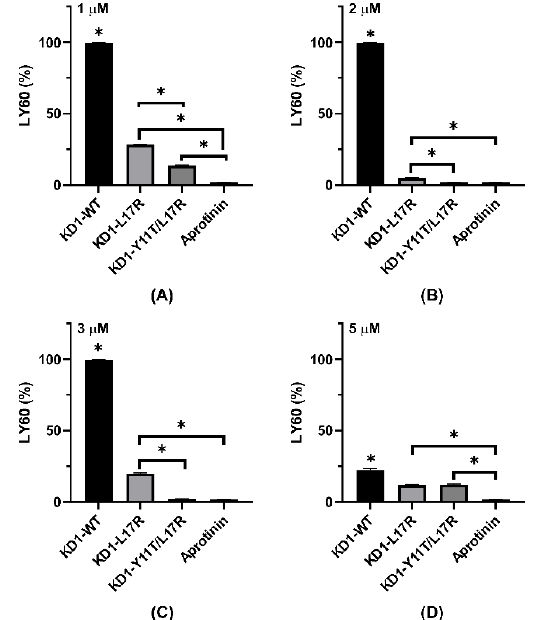
Figure 10. Comparison of LY60% (TEG experiments) for KD1-WT, KD1-L17R-K COOH , KD1- Y11T/L17R-K COOH and aprotinin at different concentrations. Bar graphs showing the percent lysis at 60 min are depicted. Panel ( A ), 1 µ M; panel ( B ), 2 µ M; panel ( C ), 3 µ M; and panel ( D ), 5 µ M. All experiments were performed in duplicate and the mean ± SD values are presented. Note: The * without bar represents significant difference from all other agents listed. The * indicates p < 0.05.